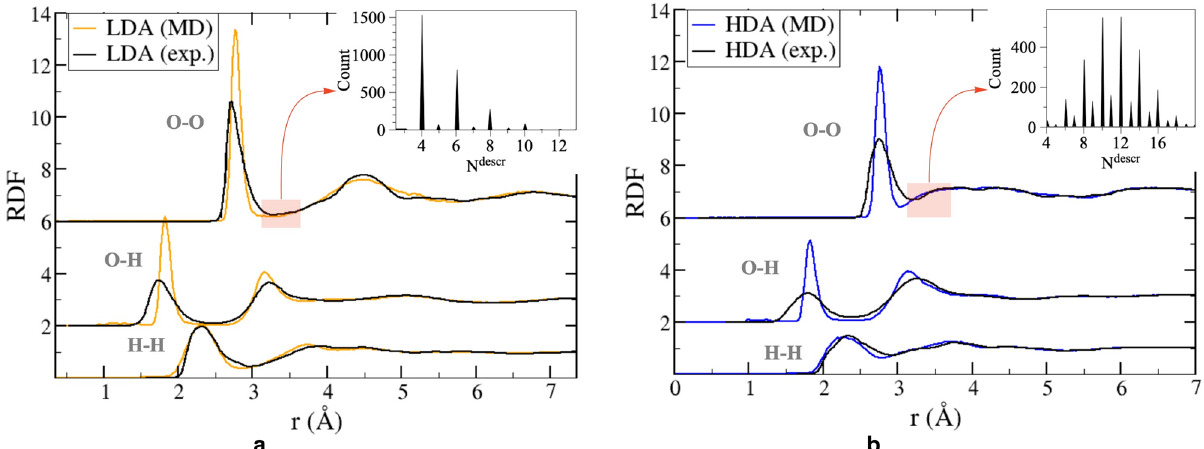
Figure 3. The radial distribution functions of LDA ( a ) and HDA ( b ) at T = 77 K and P = 0.1 MPa for TIP4P/ Ice water model and the experimental data 31 . The corresponding distributions of oxygen atoms with respect to N descr (the number of neighbours in the spherical layer 3.1 < r < 3.7 Å) are given in the upper right corners of ( a ) and ( b